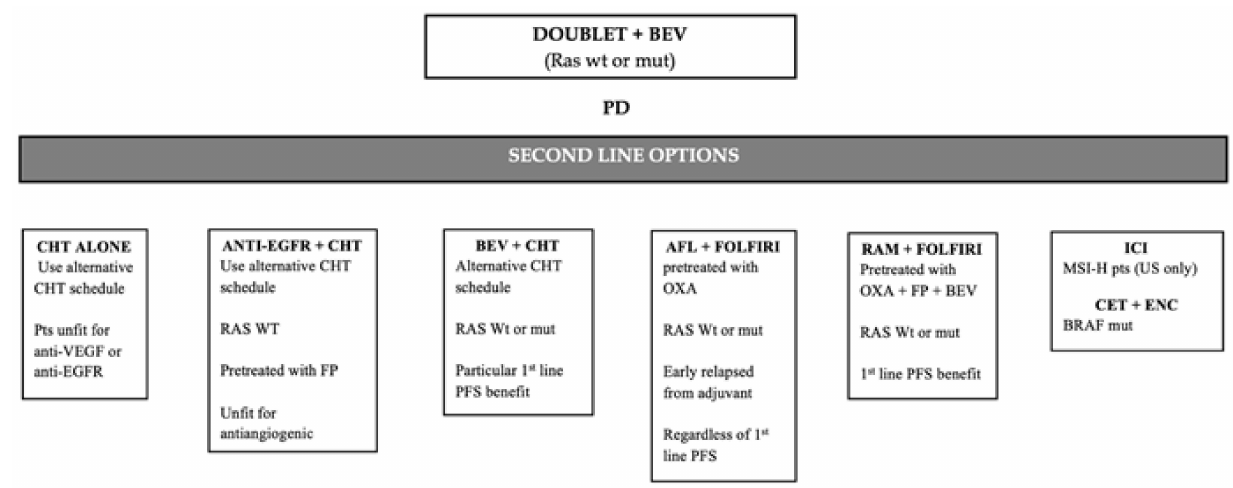
Figure 1. Second-line therapeutic options after disease progression to a doublet + Bevacizumab first line therapy. PD: progression disease; BEV: Bevacizumab; CHT: chemotherapy; wt: wild-type; mut: mutant; IRI: Irinotecan; FP: fluo- ropyrimidines; AFL: Aflibercept; OXA: Oxaliplatin; RAM: Ramucirumab; FP: fluoropyrimidines; ICI: immune-checkpoint inhibitors; US: United States; CET: Cetuximab; ENC: